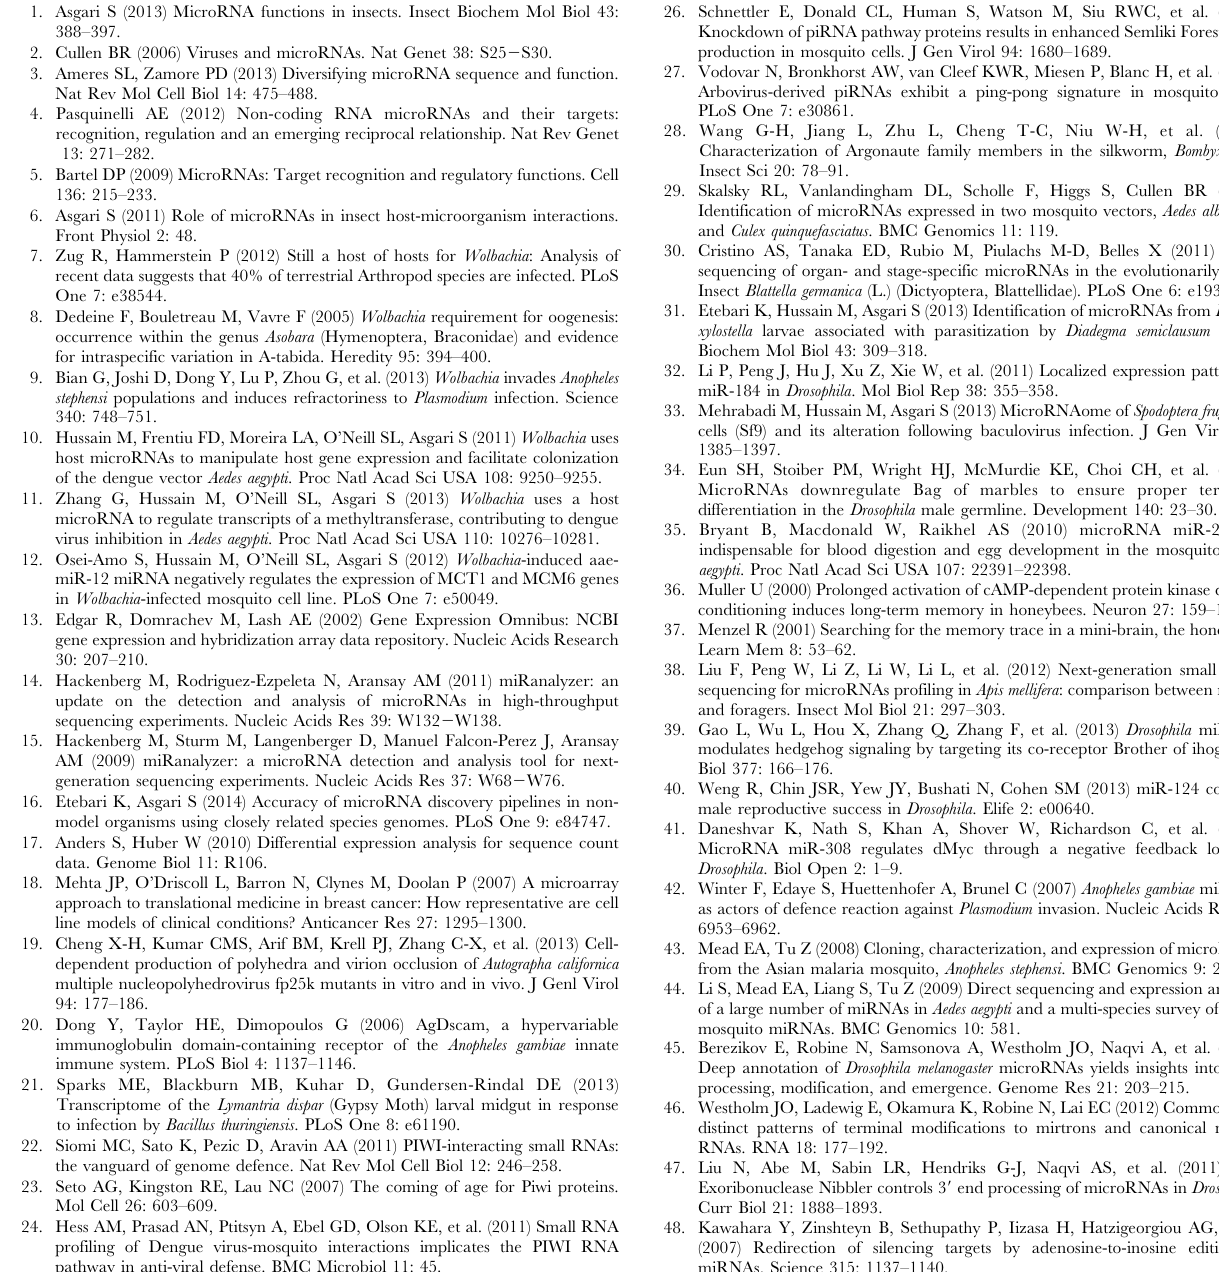
Table S1 A complete list of all miRNAs identified in the four libraries with their count